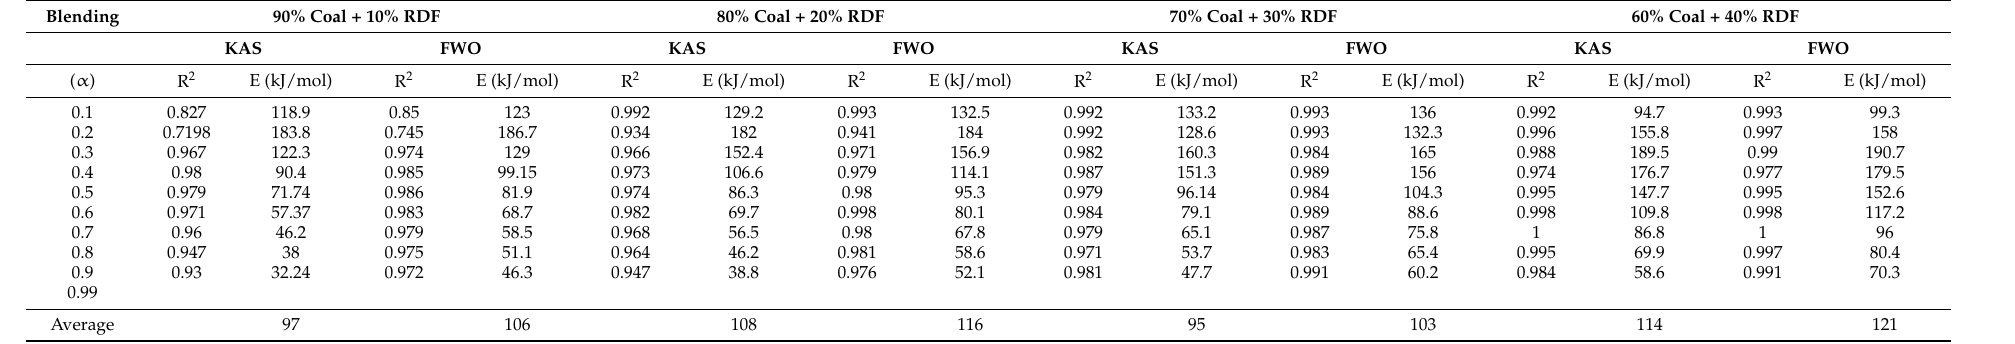
Table 3. Kinetic parameters of combustion of coal, RDF, and coal/RDF